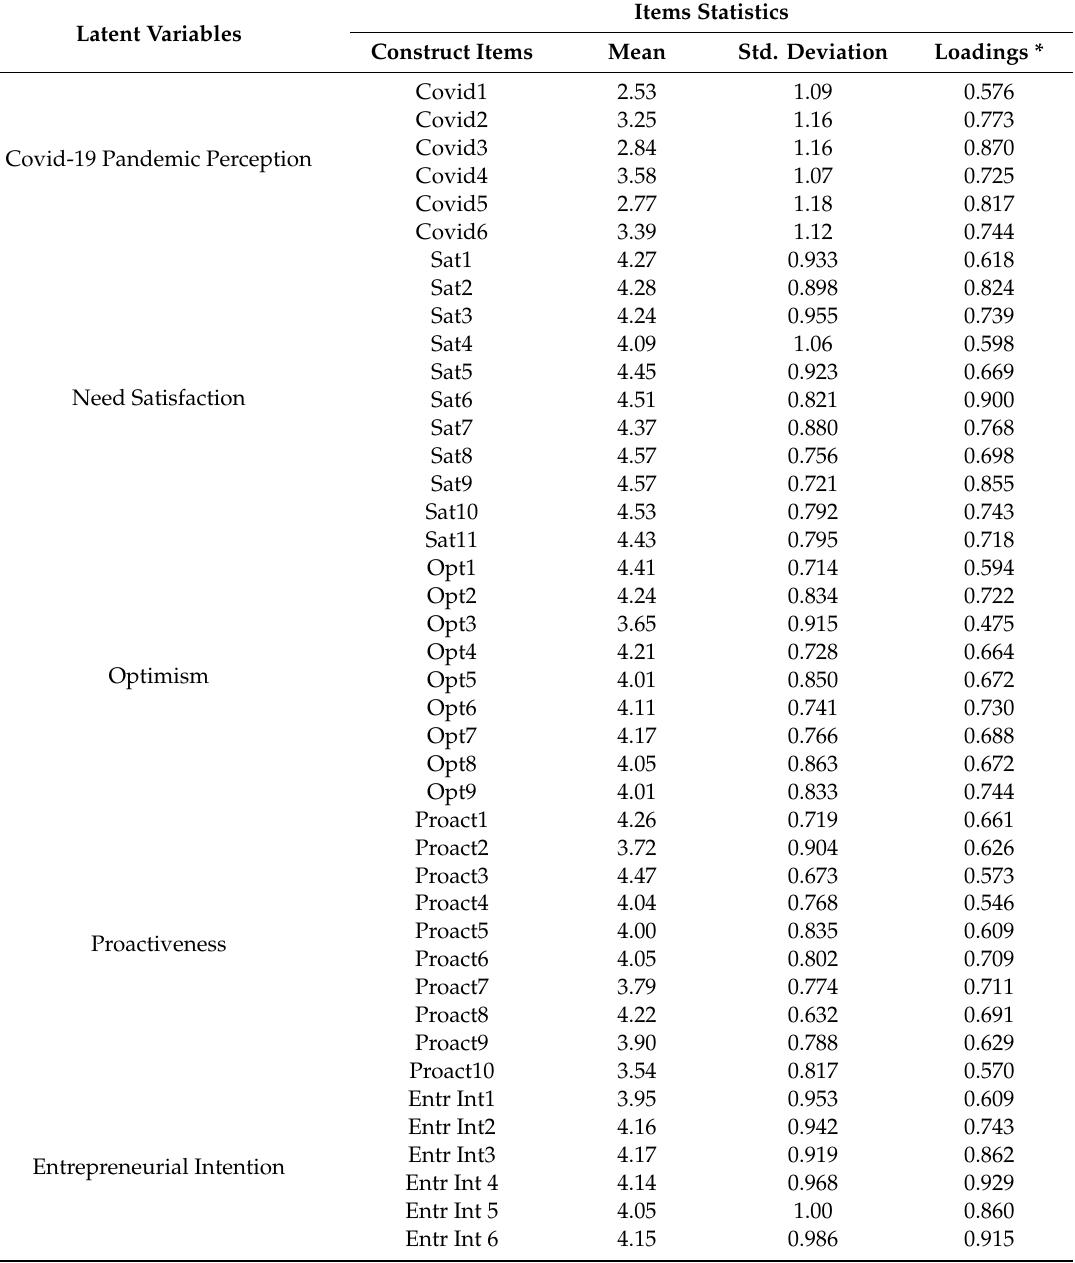
Table A1. Reliability analysis of